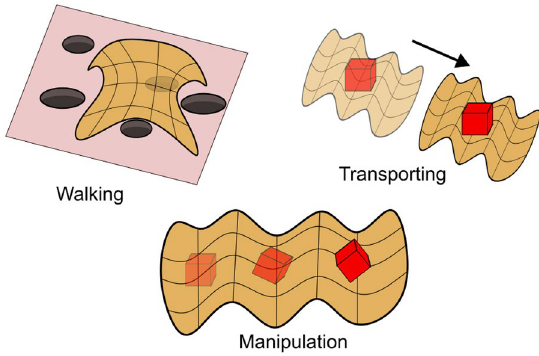
Fig. 2 The function of the mesh structure in a sheet-like